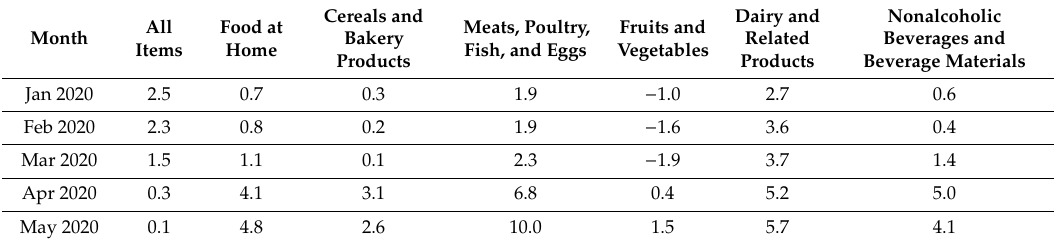
Nonalcoholic Beverages